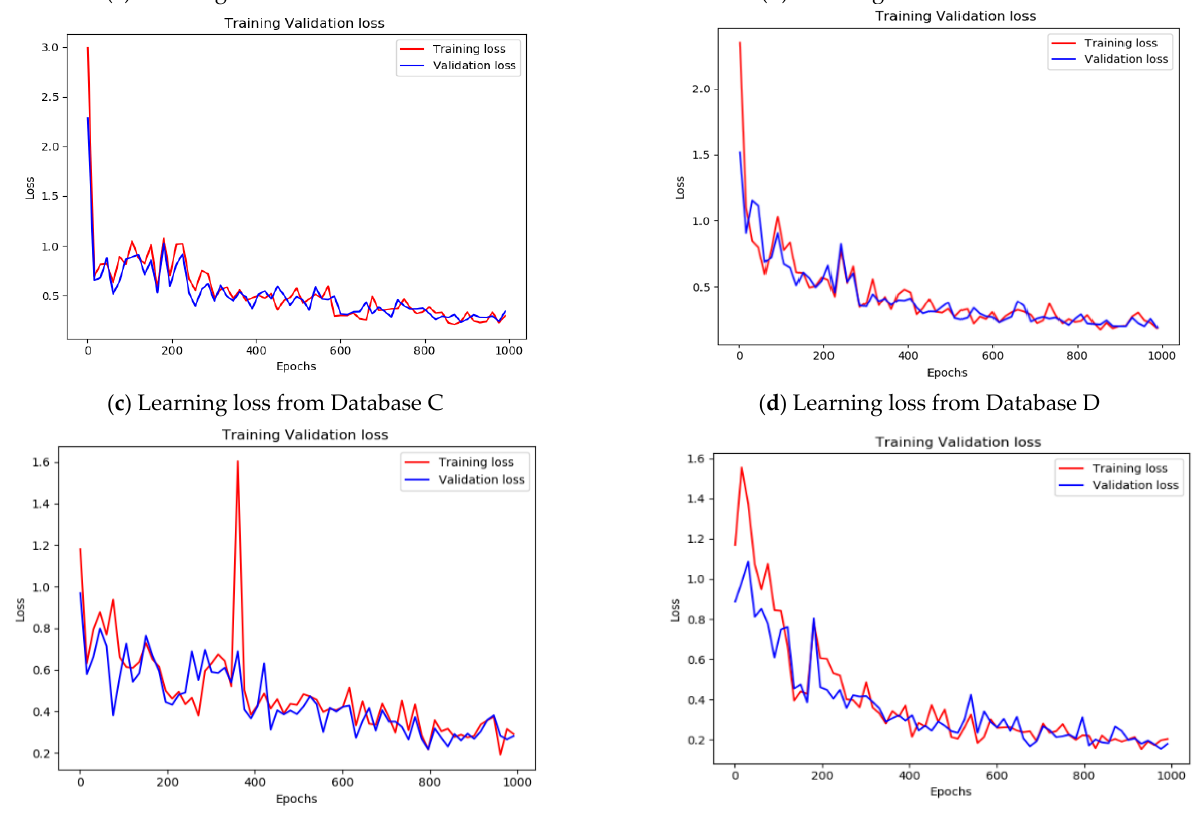
Figure 9. The average learning loss for two types of specimens: plexiglass ( a , b ); CFRP ( c , d ) .